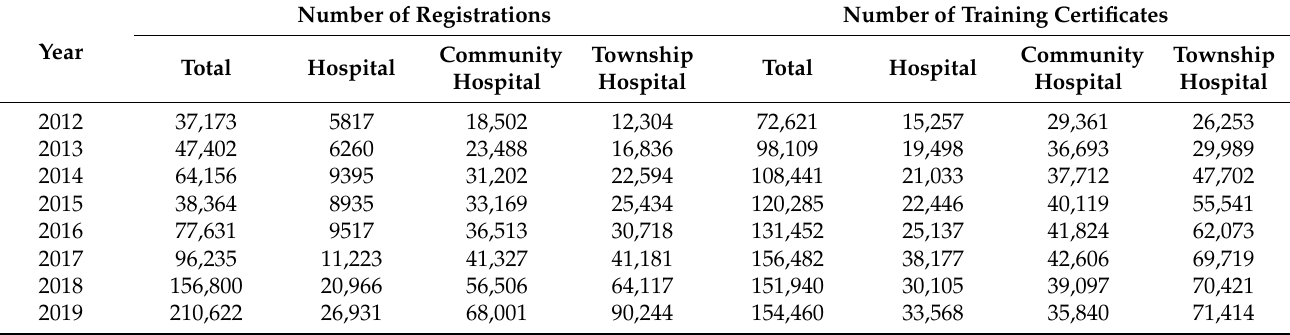
Table 5. Institutional distribution and registration of GPs in China in 2012–2019.